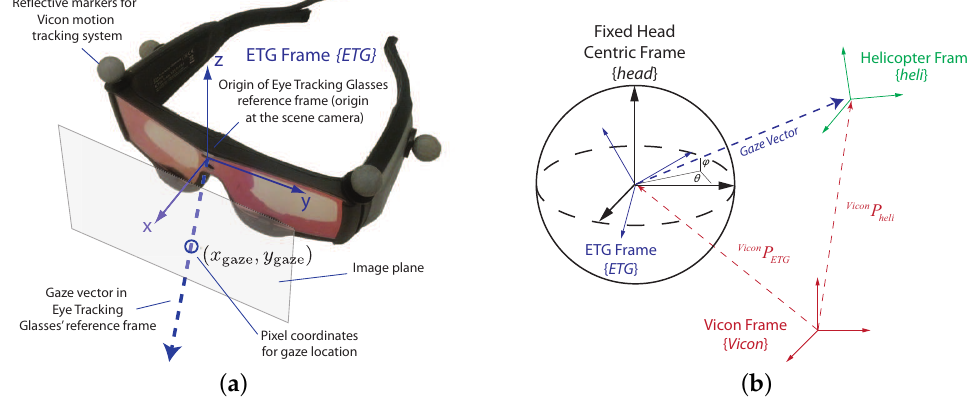
Figure 12. Reference Frames for Generating 3D Gaze Location. ( a ) Eye Tracking Glasses Reference Frame. ( b ) Spherical Reference